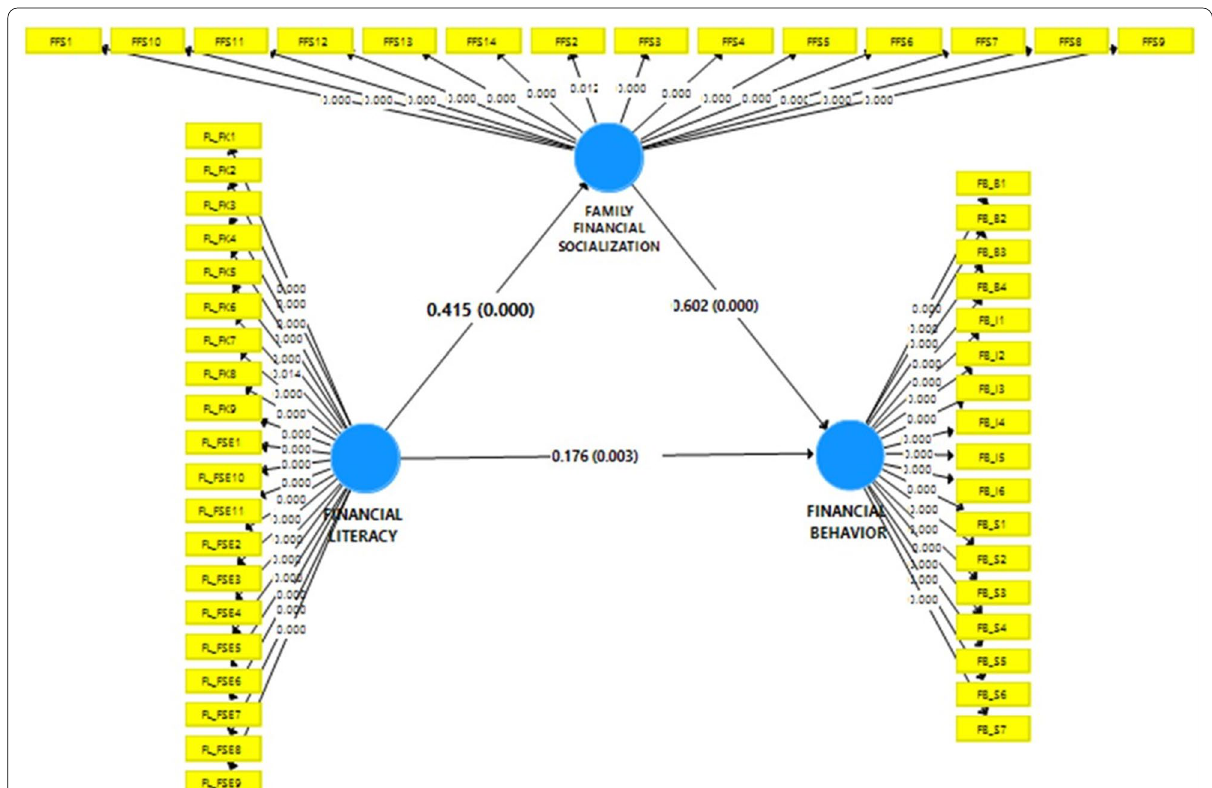
Fig. 1 Conceptual Framework of Family Financial Socialization mediating Financial Literacy and Financial